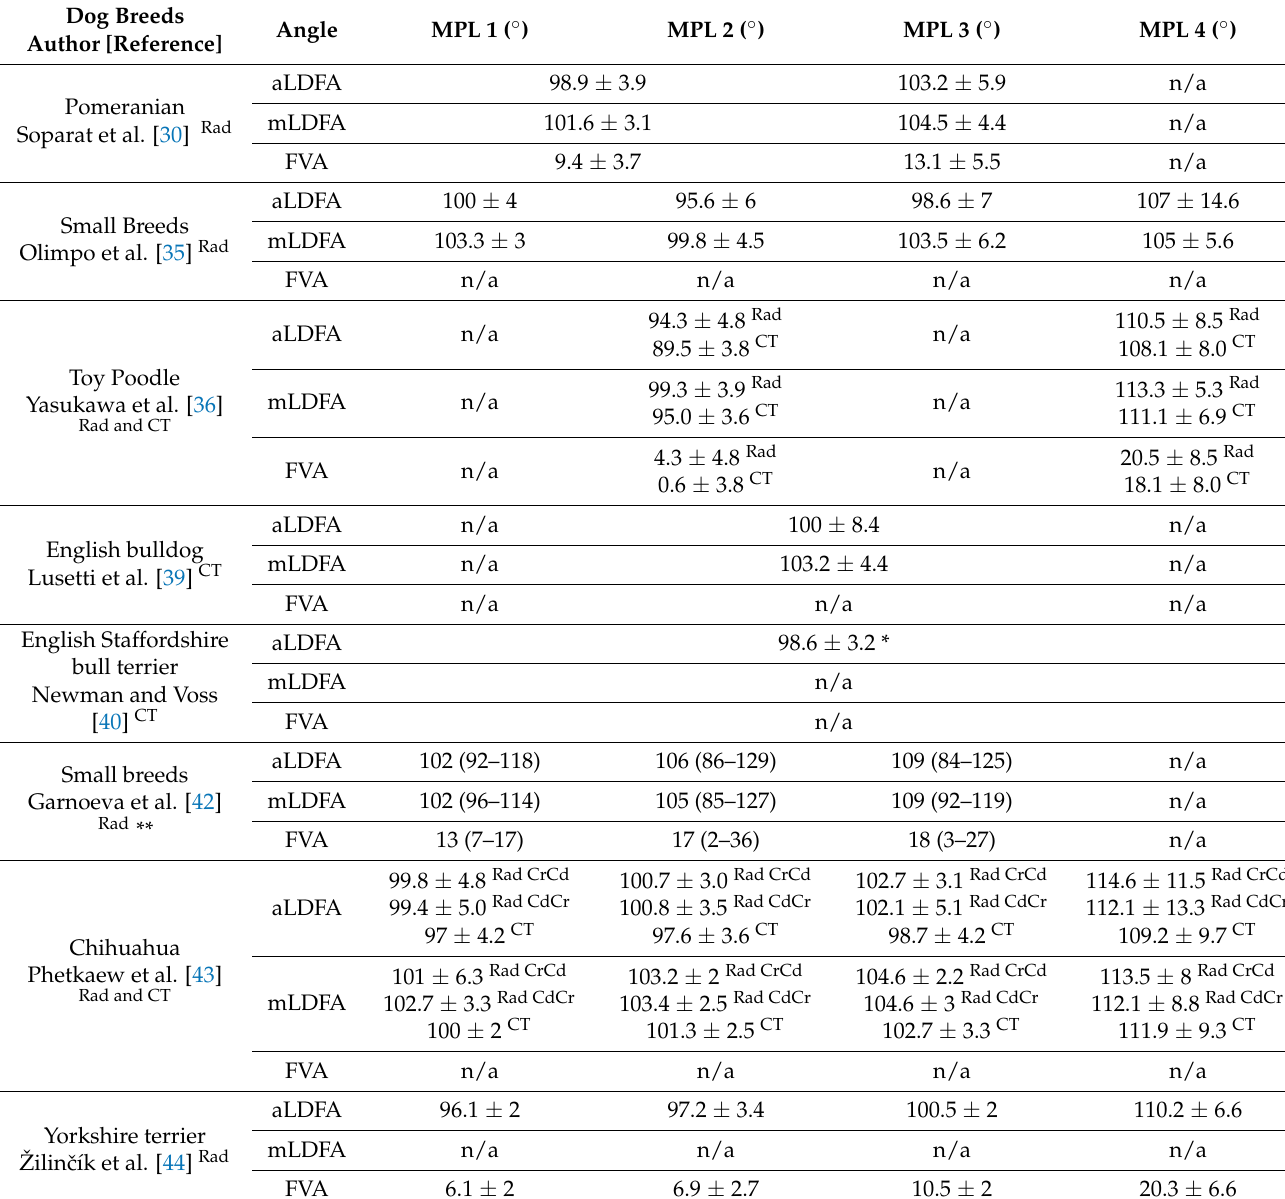
Table 9. Mean ± standard deviation of anatomical lateral distal femoral angle, mechanical lateral distal femoral angle, and femoral varus angle in dogs with different grades of